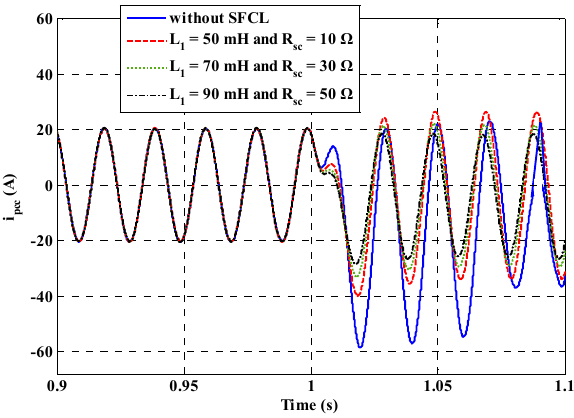
Figure 9. Fault current from the micro ‐ grid side to the PCC under the external fault (A ‐ phase).